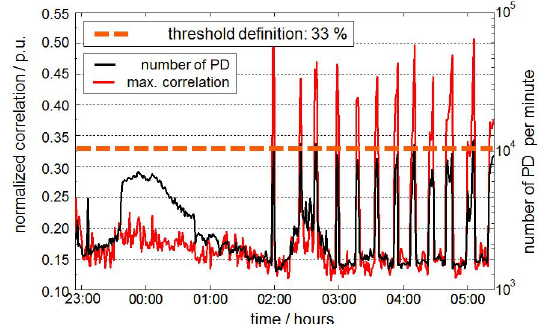
Figure 8. Number of PD per minute and correlation coefficient [14].